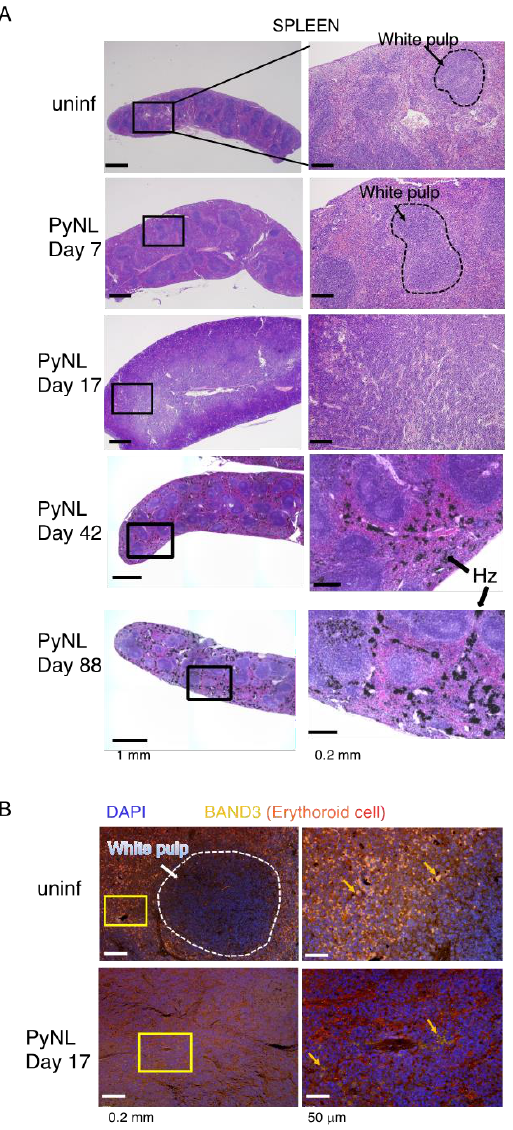
Figure 3. PyNL (blood-stage) infection changes the structure of the spleen. A typical white pulp region in uninfected (uninf) and day 7 PyNL-infected spleens are surrounded by a dashed line. Right panels show enlarged versions of indicated area in the left panel. ( A ) H&E-stained spleens of uninfected and PyNL-infected mice at day 7, day 17 (around peak parasitemia), day 42 (recovered) and day 88 (recovered) are shown. Hemozoin (HZ; black color; indicated by black arrow) was seen in red pulp at day 42 and day 88 post-infection. ( B ) Immuno-staining for BAND3 (erythroid cells; yellow, red, orange) and DAPI (nucleus; blue). Orange arrows indicate examples of positive cells.